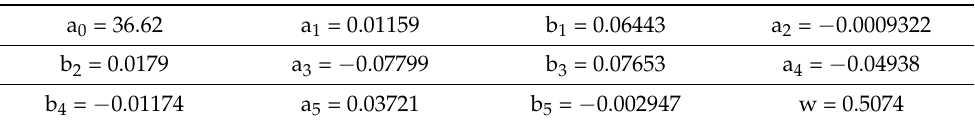
Table 6. The sym series wavelet packet base corresponded to the parameter values of the SNR fit